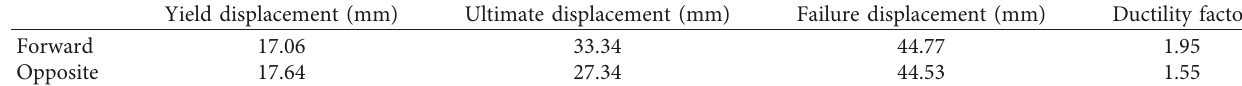
Table 3: Displacements and ductility of the NPGCS spatial